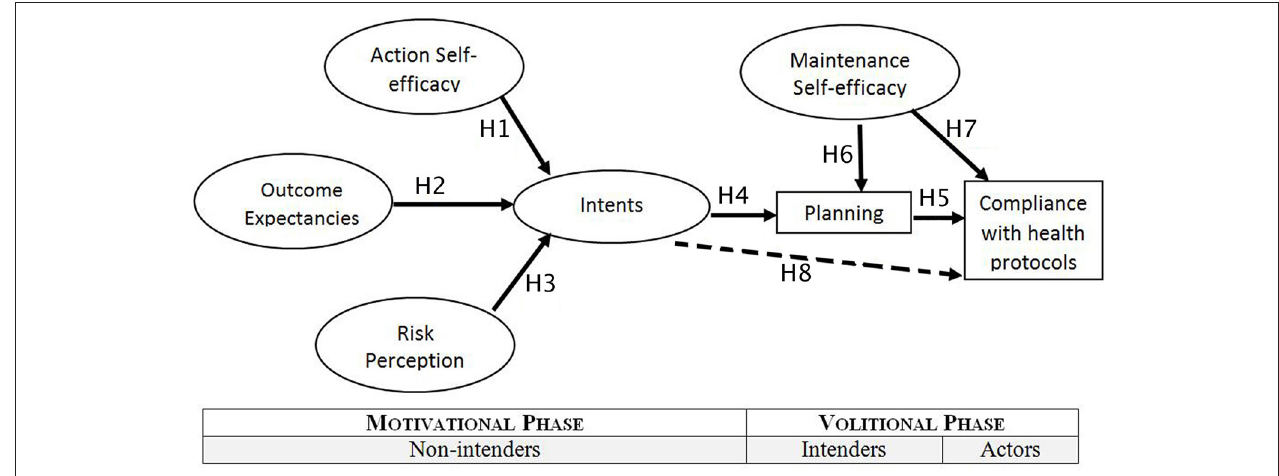
FIGURE 1 | Hypothesis model in this study, adapted from Schwarzer (18), with